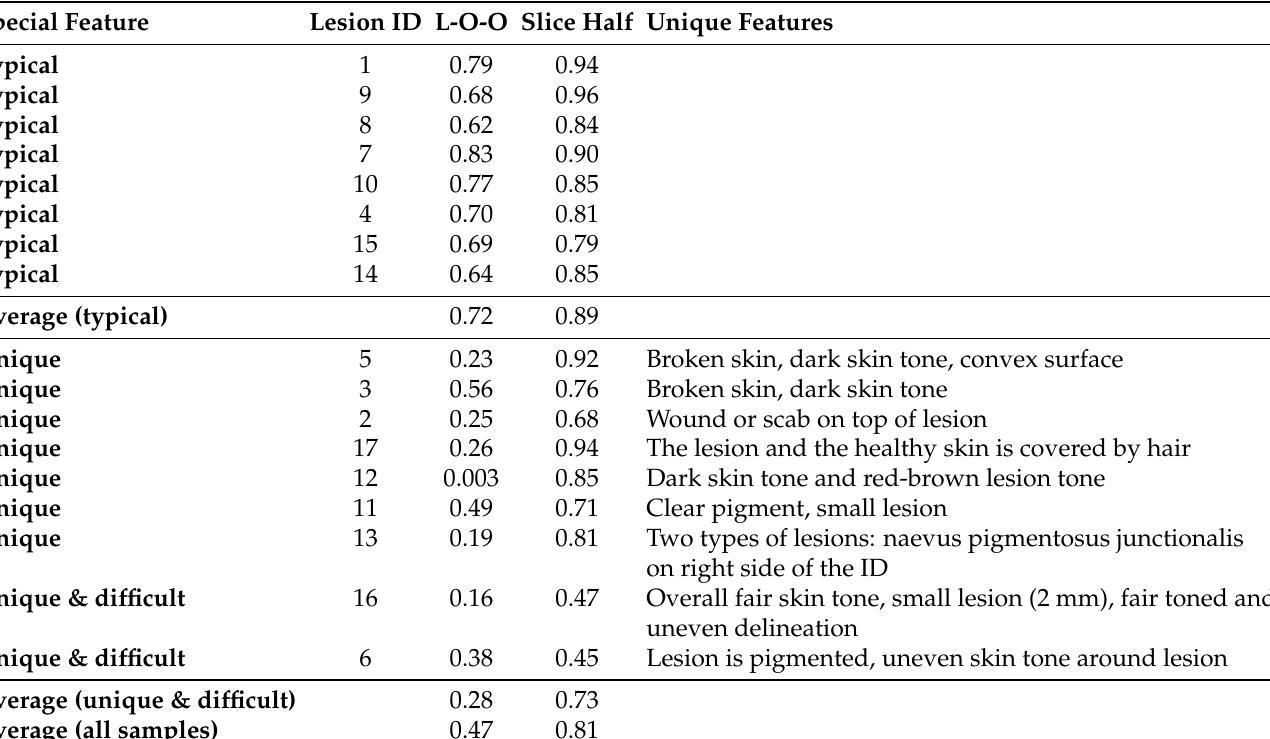
Figure 20. Comparison of pixel-wise accuracy results. Y-axis represents the results obtained with model trained and tested with sliced data. X-axis visualises the classification accuracy of leave-one- out models. The details of every HS image with RGB reconstructions can be seen in Appendix A. Grey, red and purple colours indicate the special features and the models’ capability of classifying typical (grey), unique (red), difficult and unique (purple) lesions in this test set. Table 4. Leave-one-out (L-O-O) and slice half pixel classification